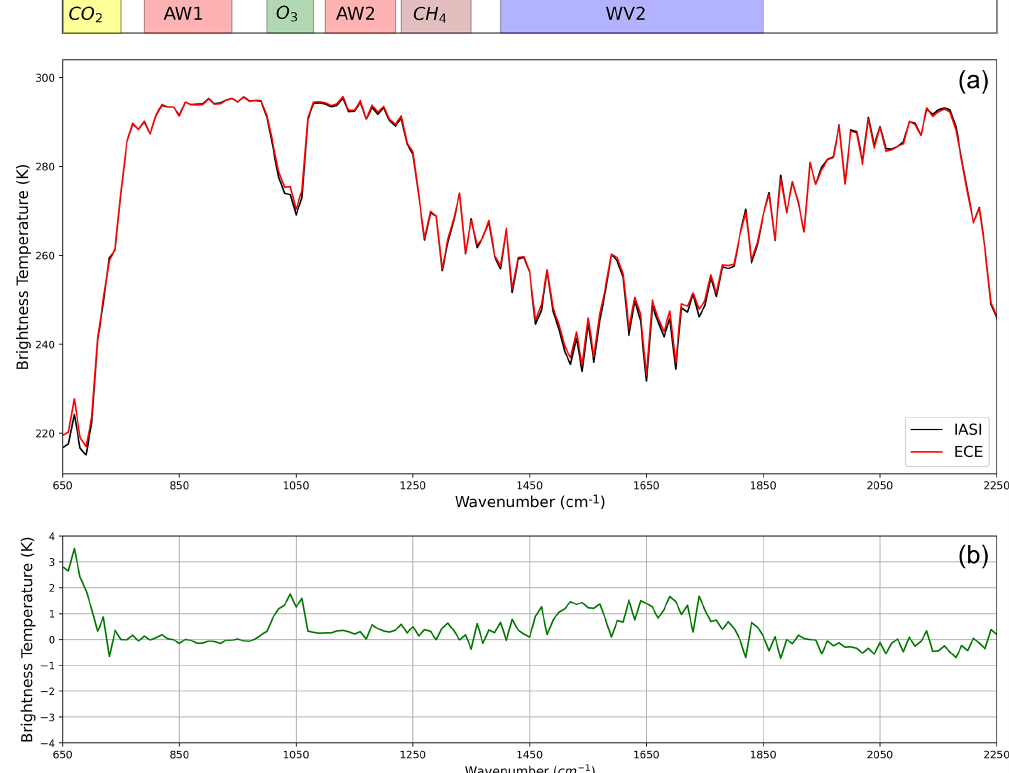
Figure 4. Average (2008–2016) brightness temperatures computed by EC-Earth and measured by IASI over the tropical ocean (30 ◦ S, 30 ◦ N) are shown in panel (a) . Panel (b) shows the BT differences (model minus